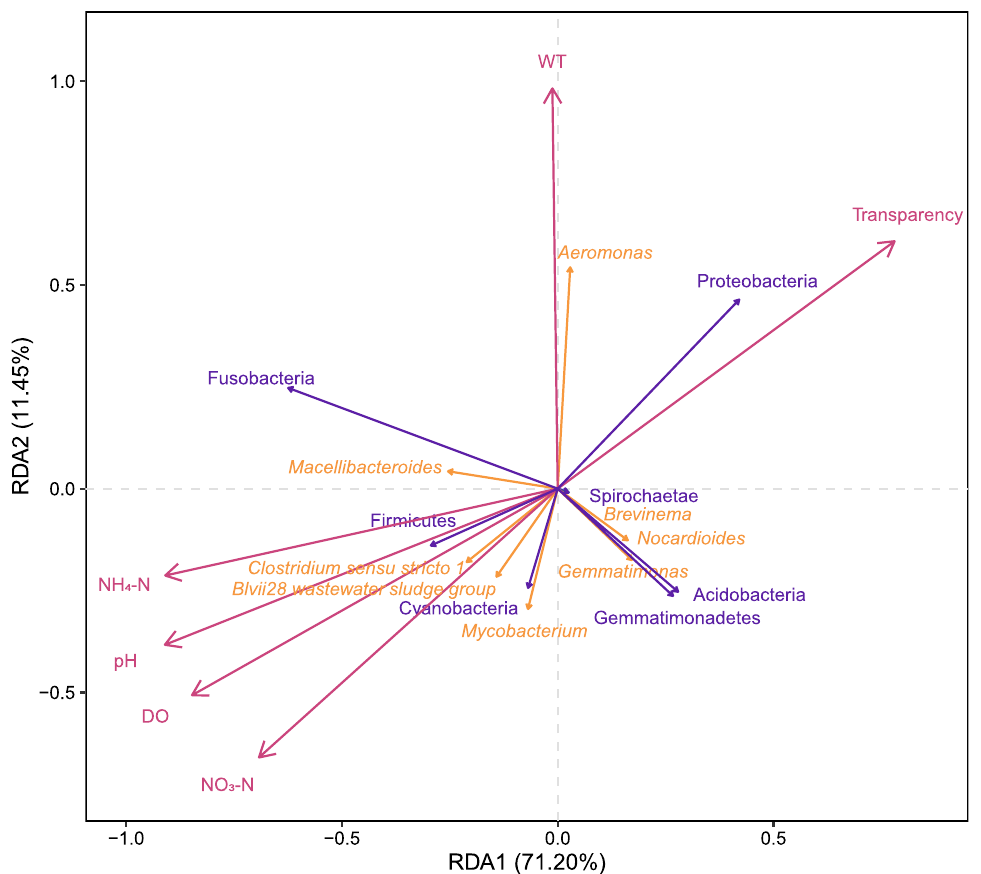
Fig. 5 The correlation among samples, environmental factors, and significant microbes. Blue and yellow arrows indicate vectors of significant microbes at the phylum and genus levels, respectively, while red arrows represent vectors of environmental factors. A positive correlation is indicated when the angle between vectors is less than 90°, while a negative correlation is indicated when it is greater than 90°. The vectors are perpendicular to each other to indicate